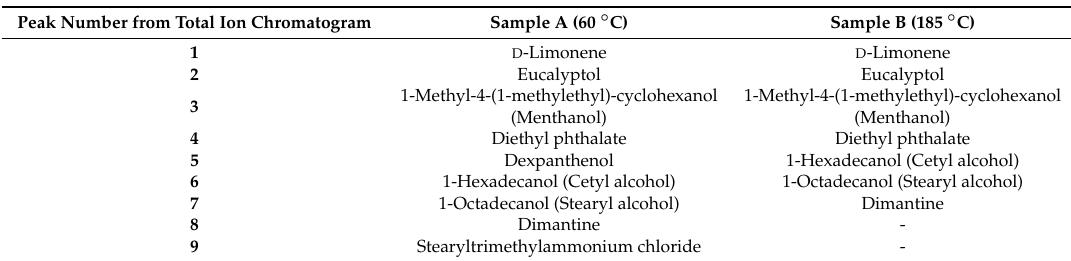
Figure 2. Representative total ion chromatograms of matched unheated ( black ) and heated ( grey ) samples with heating to 60 °C ( A ) or 185 °C ( B ). Numbered peaks were those identified by comparison to a known spectra library (see text for details). Unlabeled peaks in the chromatograms were also found in blank injections and were thus not subject to identification. Table 1. Compounds identified in hair cleansing conditioner products during Gas Chromatography- Mass Spectrometry (GC-MS) analysis.